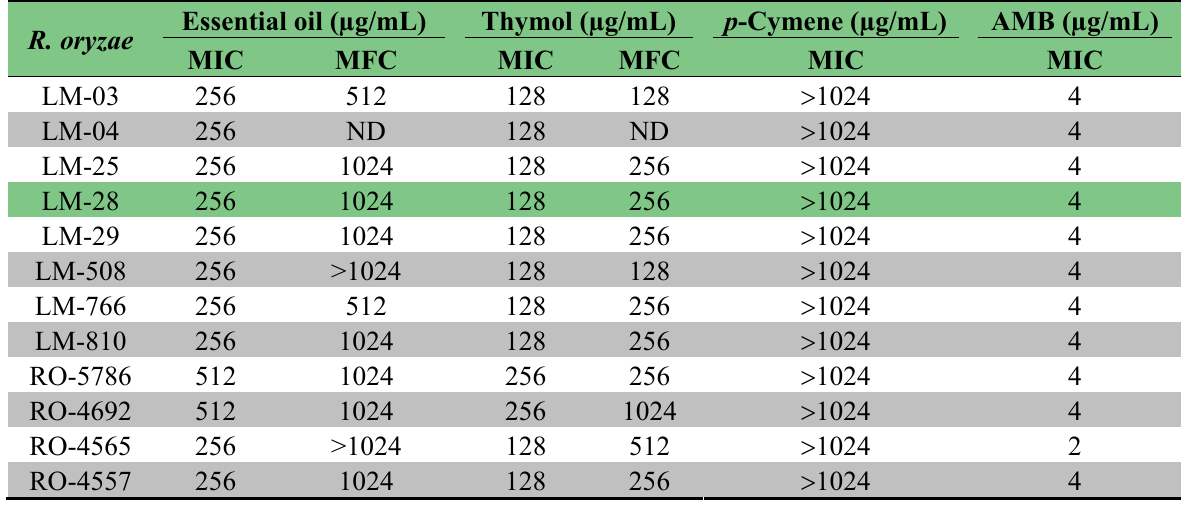
Table 3. Minimal inhibitory concentrations (MIC) and minimum fungicidal concentrations (MFC). R.